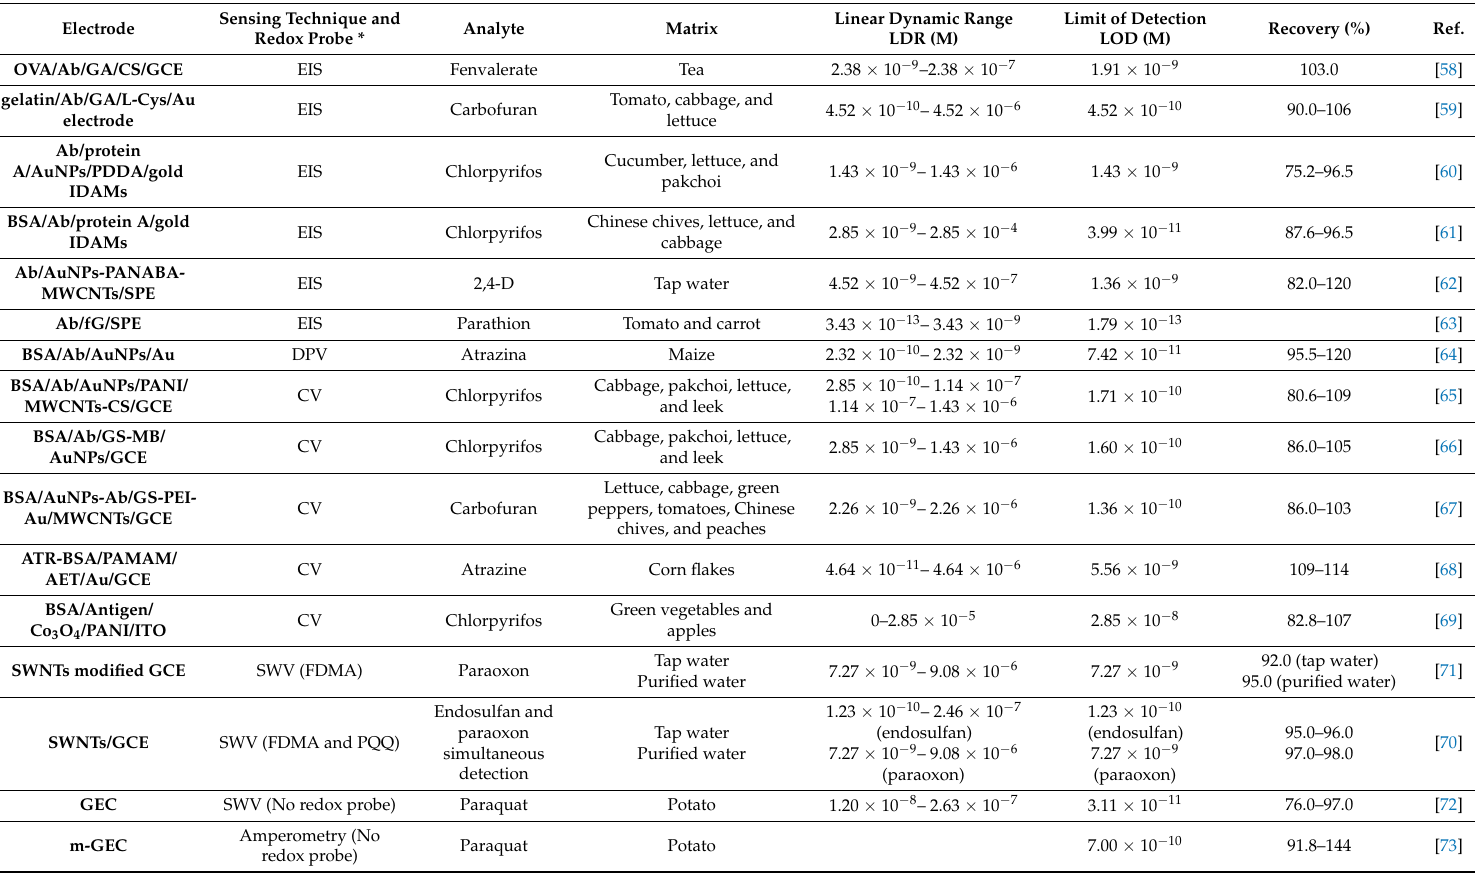
Table 1. Electrochemical immunosensors for pesticides detection in food: main features and